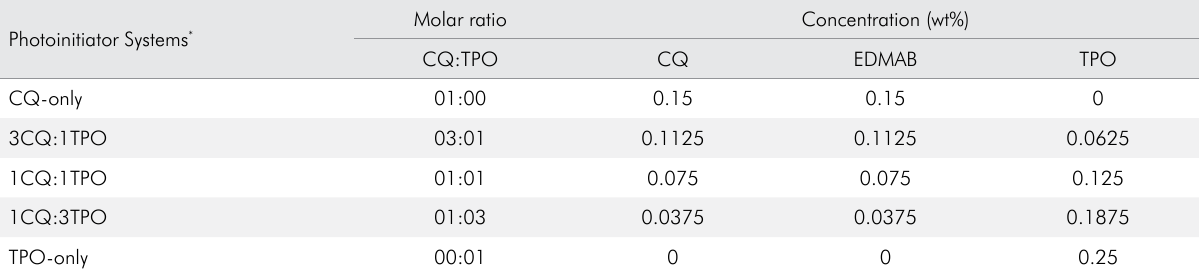
Table 2. Photoinitiator systems used in the etch-and-rinse and self-etch adhesives. Photoinitiator Systems